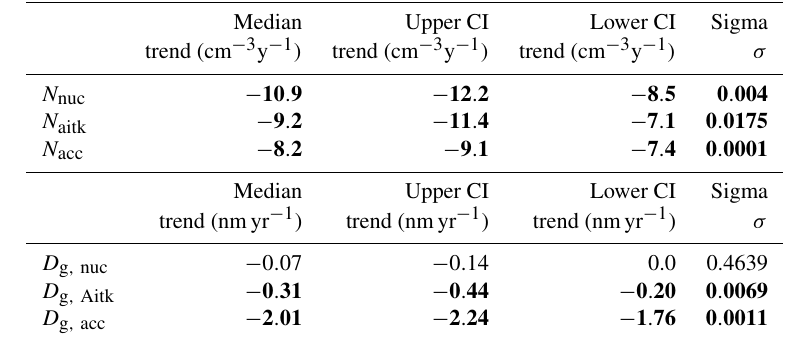
Figure 9. Trends of fitted log-normal parameters 2000–2017 of nuclei, Aitken and accumulation modal diameter and modal concentration. Panels (a) – (c) show trends for fitted geometric modal diameter, and panels (d) – (f) show trends for fitted modal number concentration. Whiskers indicate the 25th–75th percentiles of data. Fitted trend (as Theil–Sen estimator) slope is given in each title. Upper and lower 95% confidence intervals of slopes are indicated in figures. The CI of slopes is calculated following Hollander and Wolfe (1973). Table 3. Theil–Sen estimator slope of fitted variables D g and N and associated upper and lower confidence intervals during the time period 2000–2017. Bold values indicate significance on the 0.05 level according to the seasonal Kendall test (based on 12 months). Calculated σ from seasonal Kendall test is indicated. Trend of D g for nuclei mode is not significant on the 0.05 significance level. Upper and lower CIs calculated following Hollander and Wolfe